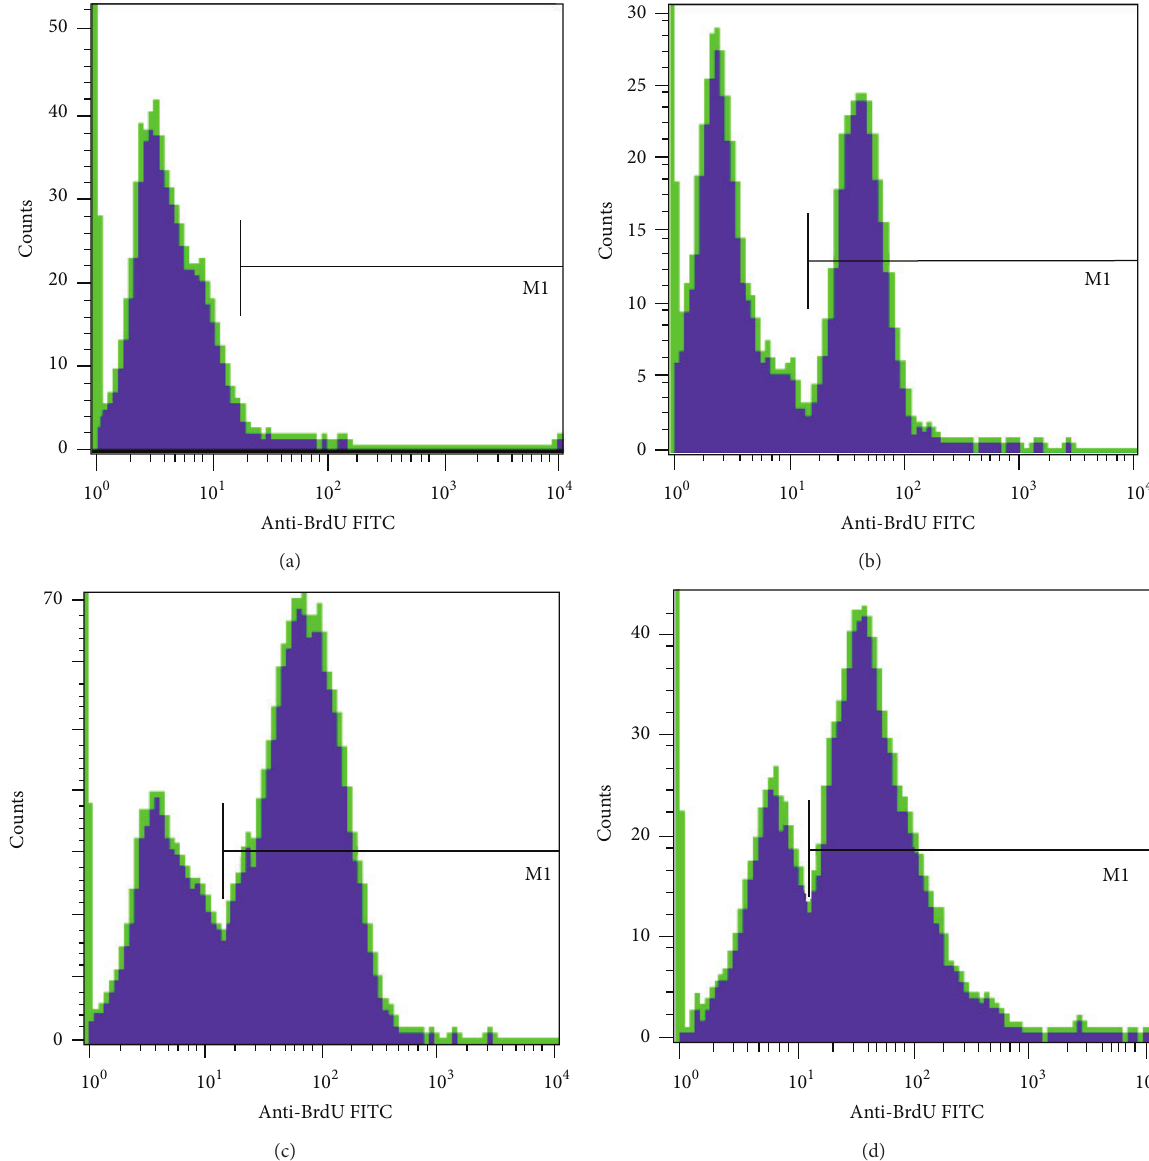
Figure 4: Effects of LPLI on the number of myoblasts in S phase of the cell cycle by flow cytometric analysis of BrdU incorporation after pretreatment with serum starvation. Representative histograms of flow cytometry analysis for BrdU-labeled cells from control (a), laser irradiation for 3 min (b), 10% FBS (c), and 20% FBS (d) group,